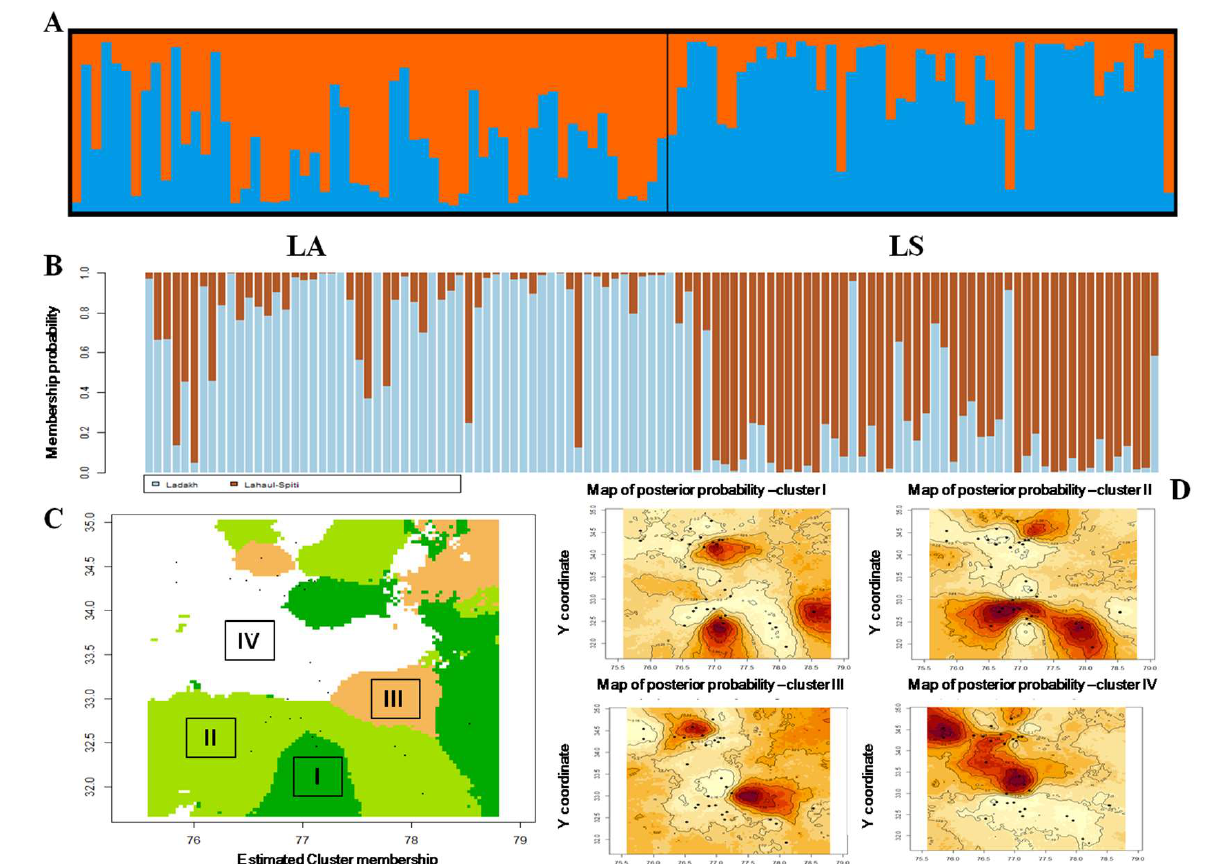
Figure 4. ( A ) Bayesian clustering using STRUCTURE at K-2 with ibex individuals (LA-60, LS-51). ( B ) Non-Bayesian clustering using DAPC with 111 ibex individuals. ( C ) Estimated cluster membership shows spatial distribution of the four inferred genetic clusters across the study areas in Geneland using ibex individuals (K = 4 gives the best run showing highest average posterior probability). ( D ) Maps of posterior probability for each inferred cluster show the spatial location of genetic discontinuities of clusters I, II, III and IV, whereas sample locations are represented by black dots.